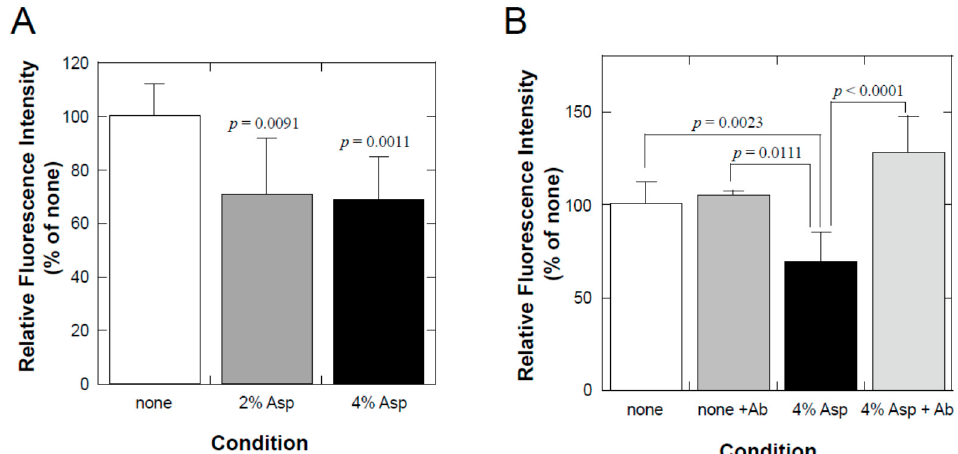
Figure 7. Effects of TL24 asparagus/milk ferments on the paracellular transfer of fluorescein through a cell sheet of human epidermal keratinocytes. ( A ) The effects of 2% and 4% of TL24 asparagus/milk ferments on the paracellular transfer of fluorescein were examined as described in the Materials and Methods section. Each bar represents the mean with S.D. of nine, four, and eight determinations for control (none), 2%, and 4% condition, respectively. Statistical significance of the test conditions vs. control was determined using the Dunnett’s test. ( B ) To determine whether this activity was via the stimulation of TLR2, the effect of a TLR2 neutralizing antibody was examined at a concentration of 1 µg/mL. Each bar represents the mean with S.D. of nine, three, nine, and nine determinations for control (none), antibody only, 4% asparagus/milk ferments only, and 4% asparagus/milk ferments with antibody, respectively. Statistical significance between the test groups was determined using the Scheffe’s test. Significant probabilities ( p -values) between groups are shown in the figures, and differences between groups are considered statistically significant when the p -value is less than 0.05.